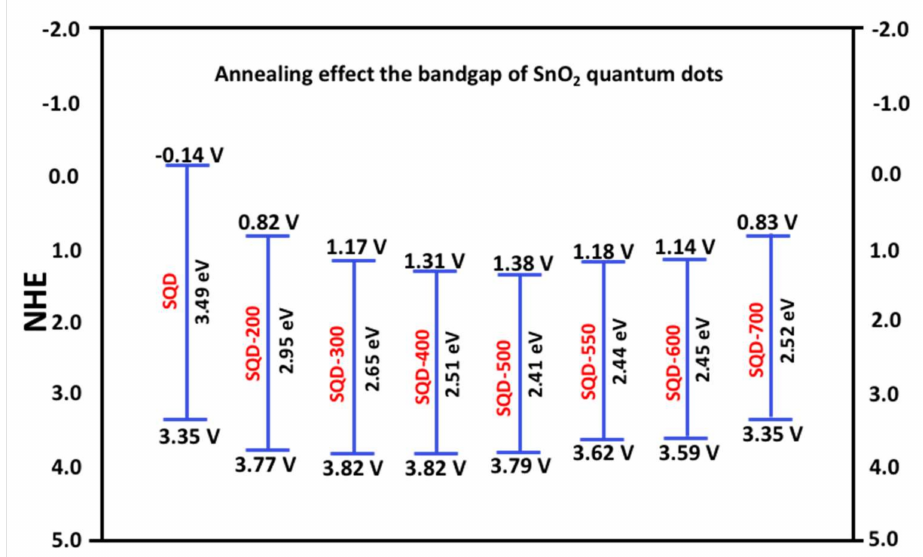
Figure 1. VB and CB edge potentials with bandgaps of SnO 2 quantum dots annealing with different temperatures. In this figure, the acronym SQD relates to the annealing temperature at ◦ C. For instance, the sample SQD-200 was annealed at 200 ◦ C. Reproduced with permission from Ref. [13]. Copyright 2018